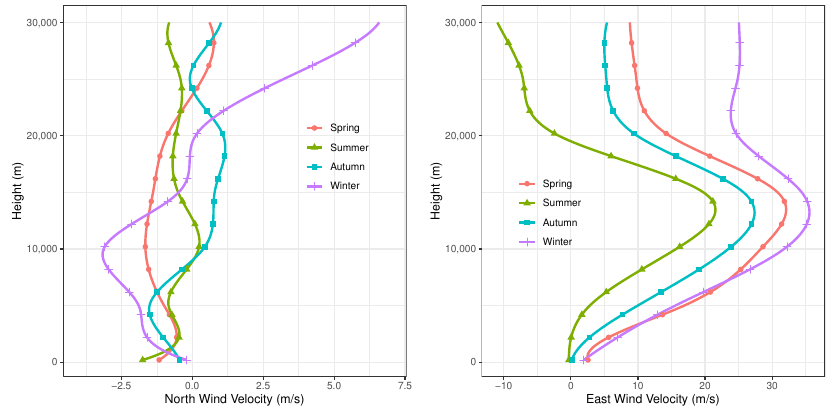
Figure 3. ( left ) North wind velocity. ( right ) East wind velocity. The summer wind field was selected as the numerical experiment environment as shown in Figure 4. Equation (9) denotes the fitting relationship between wind velocity and altitude.